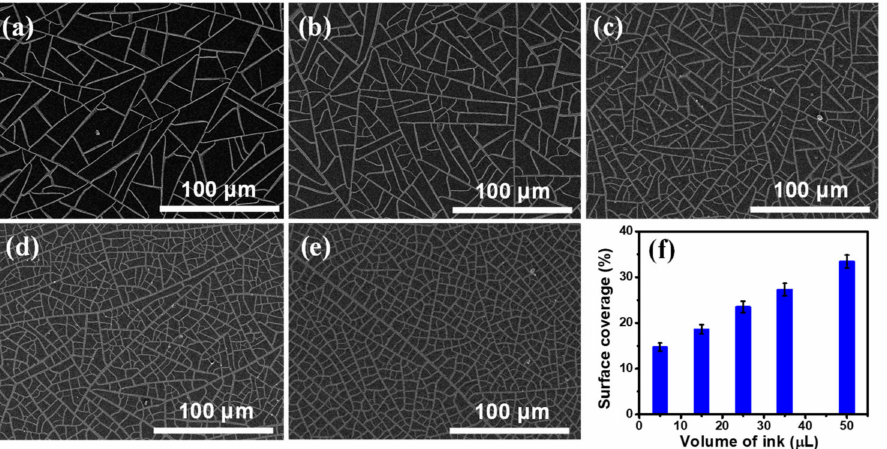
Figure 1. ( a – e ) Scanning electron microscope (SEM) images of the Ni meshes: ( a ) NM V-5, ( b ) NM V-15, ( c ) NM V-25, ( d ) NM V-35, and ( e ) NM V-50; ( f ) The surface coverage of Ni wire of each Ni mesh sample versus the volume of the ink solution. Table 1. The intensity ratios of the 2D peak over the G peak of all five graphene mesh (GM) samples.